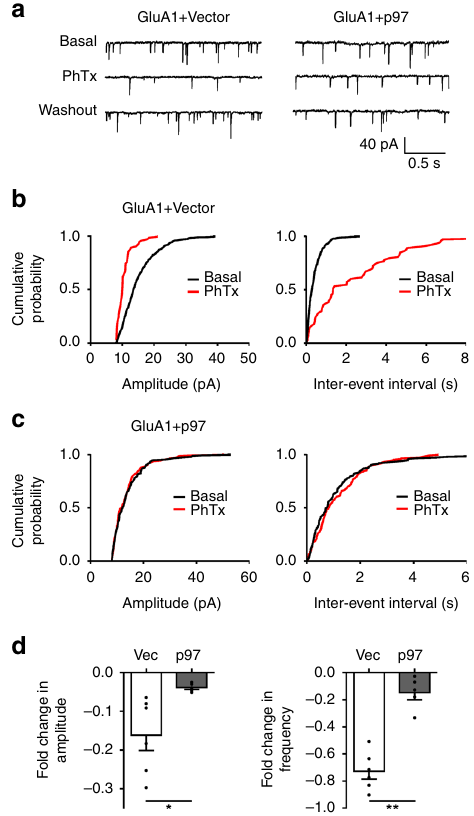
Fig. 4 p97 decreases recombinant GluA1-homo AMPAR-mediated currents in cultured hippocampal neurons. Hippocampal neurons in primary cultures were transfected with HA-GluA1 and control vector (GluA1 + Vec) or p97 (GluA1 + p97), along with GFP to detect the transfected cells for recording. mEPSCs were recorded under whole-cell voltage-clamp at a holding membrane potential of – 60 mV 48 h after transfection. Surface expression of recombinant of GluA1-homo AMPARs was inferred with the presence of the sensitive component of mEPSCs to bath application of PhTx (10 μ M). From a – e are represented traces ( a ), cumulative probability plots of amplitudes and inter-event intervals ( b , c ), and bar graphs of averaged fold changes in amplitude ( d ) and frequency ( e ) of mEPSCs recorded 5 min before (Basal) and 5 min after (PhTx) PhTx application (GluA1 + Vec: n = 6 cells; GluA1 + p97: n = 5 cells; * p < 0.05, ** p < 0.01, two-tailed t test).